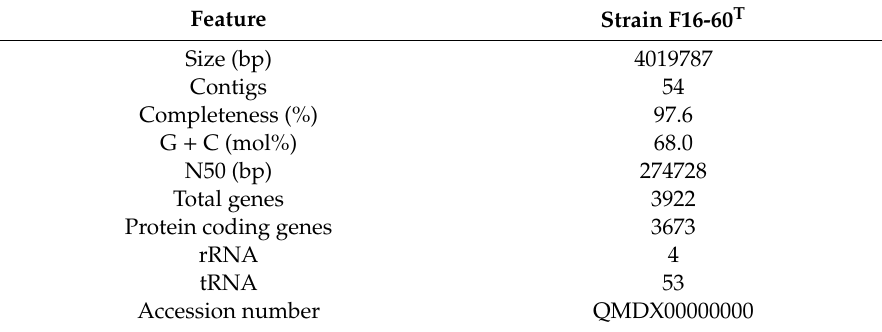
Table 3. General features of the sequenced